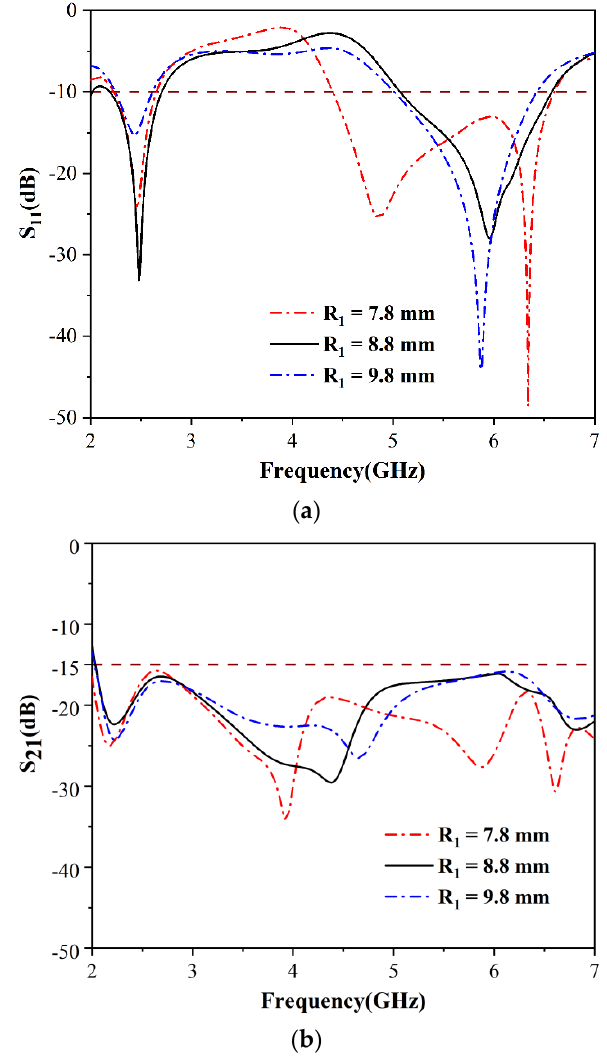
Figure 4. Simulated parameters with different values of R 1 . ( a ) Reflection coefficients; ( b ) isolation.